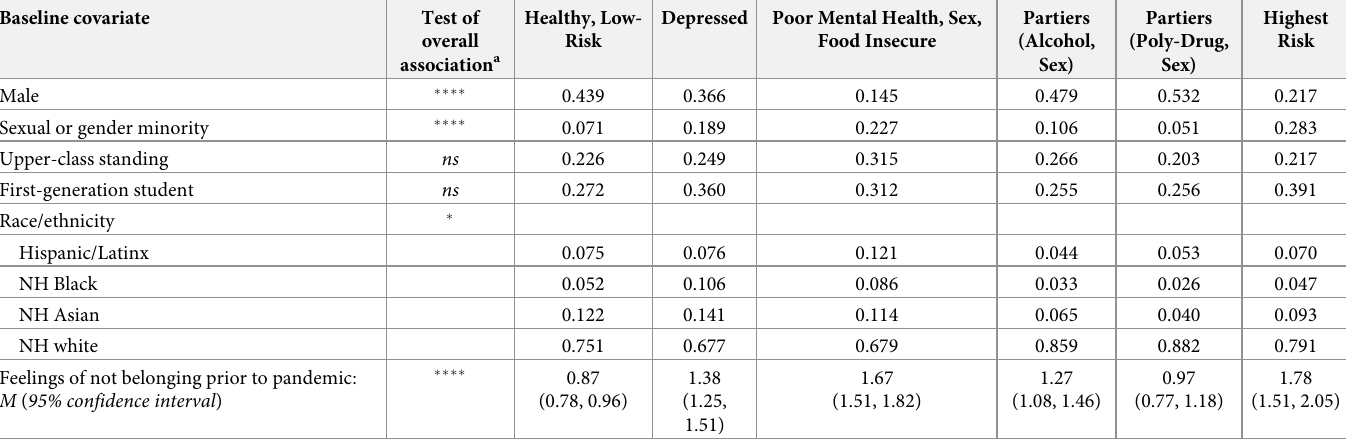
Table 6. Covariates of health and well-being latent class membership prior to the pandemic: Class-specific proportion (mean) of individuals with each characteris- tic at baseline. Baseline covariate Test of